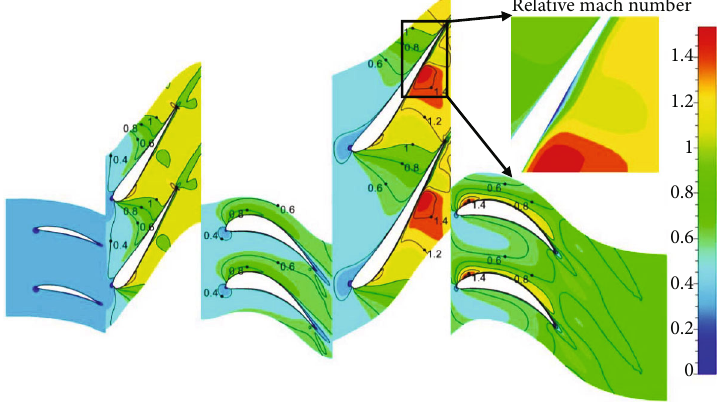
Figure 11: Relative Mach number contour at 50% blade height.